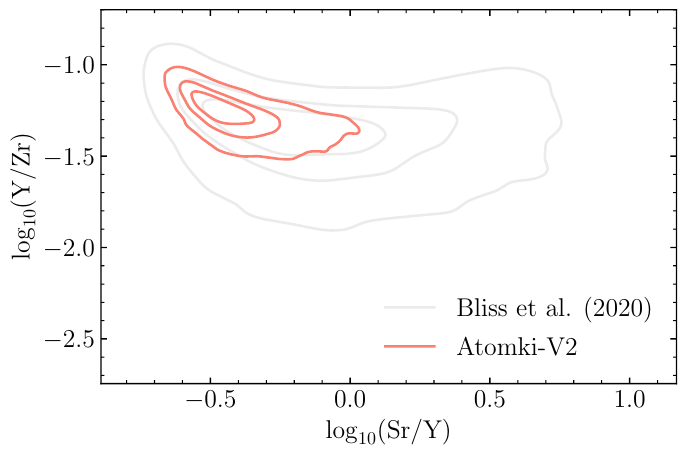
Figure 2. Kernel Density Estimate (KDE) of the Sr / Y and Y / Zr elemental ratios for the Monte Carlo study of Bliss et al. [11] using TALYS v1.6 ( α, n ) reaction rates and the present work using rates based on the Atomki–V2 α OMP [12]. The contours show the 3 σ uncertainties for each calculation. The conditions of the trajectory used are: Y e = 0 . 4, entropy s = 56 k B / nucl. and expansion time τ = 63 . 8 ms. Typical observational uncertainties are ∼ 0 . 1 − 0 . 2 dex [2].